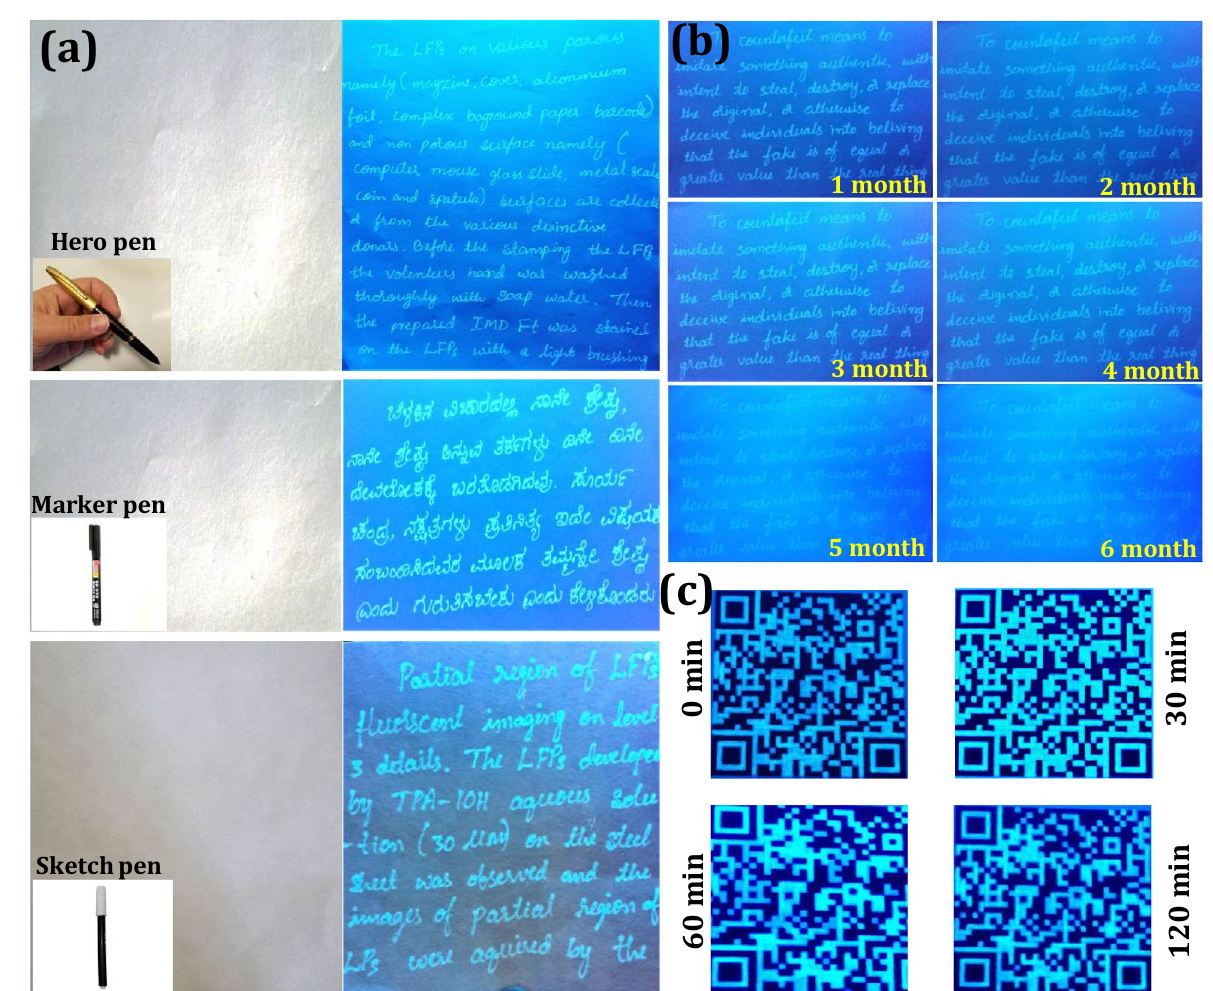
Figure 10. ( a ) Photographic images of English and Kannada words handwritten by hero pen, marker pen and sketch pen under visible and UV 365 nm light excitation; ( b ) fluorescent images of decoded anti-counterfeiting information stored in different time periods at RT; ( c ) photostability of developed QR code information treated with different UV irradiation time